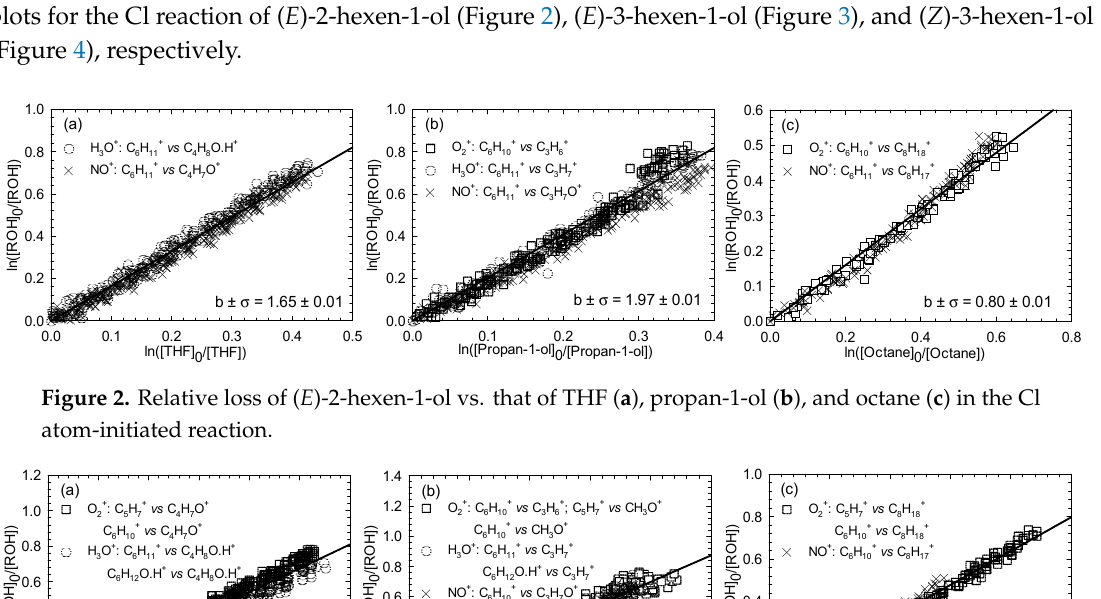
Figure 1. Relative loss of ( Z )-2-penten-1-ol vs. that of tetrahydrofuran (THF) ( a ), propan-1-ol ( b ), and octane ( c ) in the Cl atom-initiated reaction.